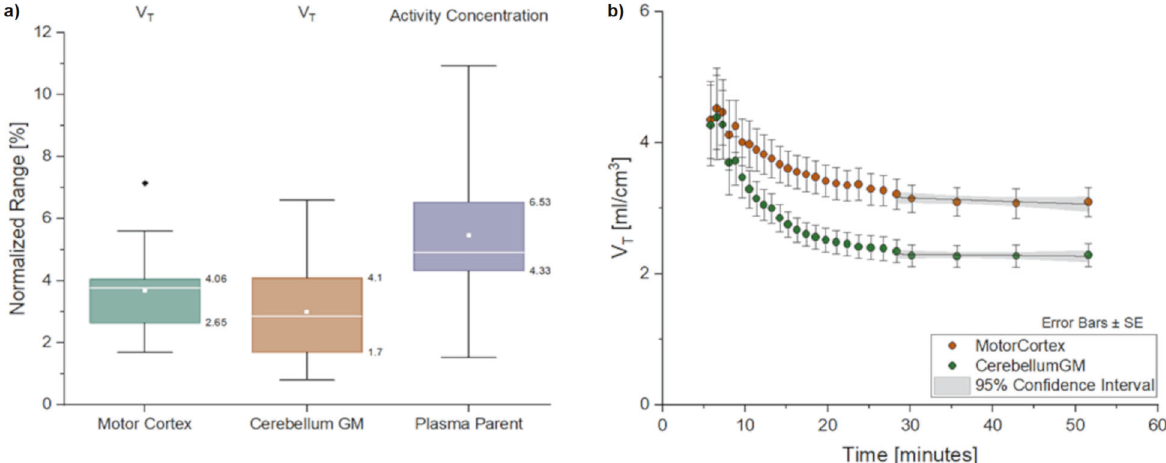
Fig. 3 Equilibrium quality evaluation/inspection represented by regional cerebral uptake of [C]ABP688 expressed as distribution volume referenced to plasma parent, V. a Normalized-range variations of the V T values in the plateau range (30 – 60 min) for the motor cortex and cerebellum GM-control regions during the equilibrium phase. The plasma parent compound normalized activity-concentration range for evaluating the equilibrium quality is also shown. b Average V T curves and the linear regression applied to the data plateau range (30 – 60 min) ffiffiffi p n for the slope analysis. SE = standard error of the mean (mean/ ), where n = sample